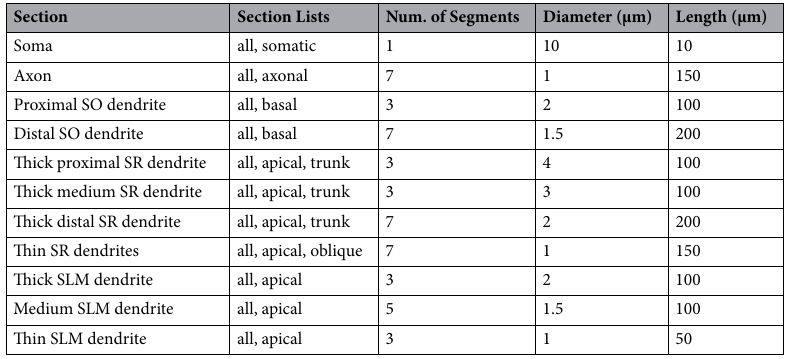
Table 1. Morphological structure of the To21 model. SO: stratum oriens, SR: stratum radiatum, SLM: stratum